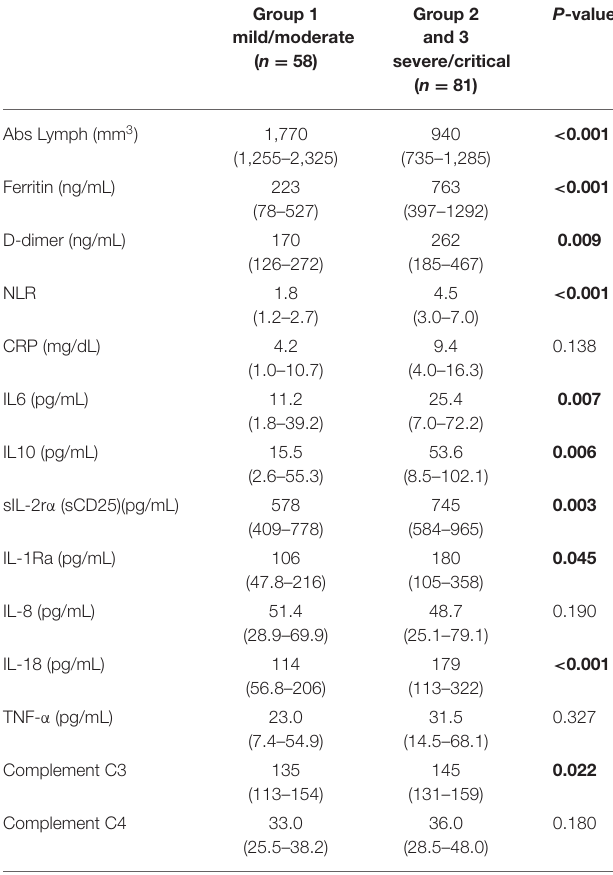
TABLE 1 | Comparison of laboratory markers and cytokine levels in mild/moderate and severe/critical COVID-19. Group 1